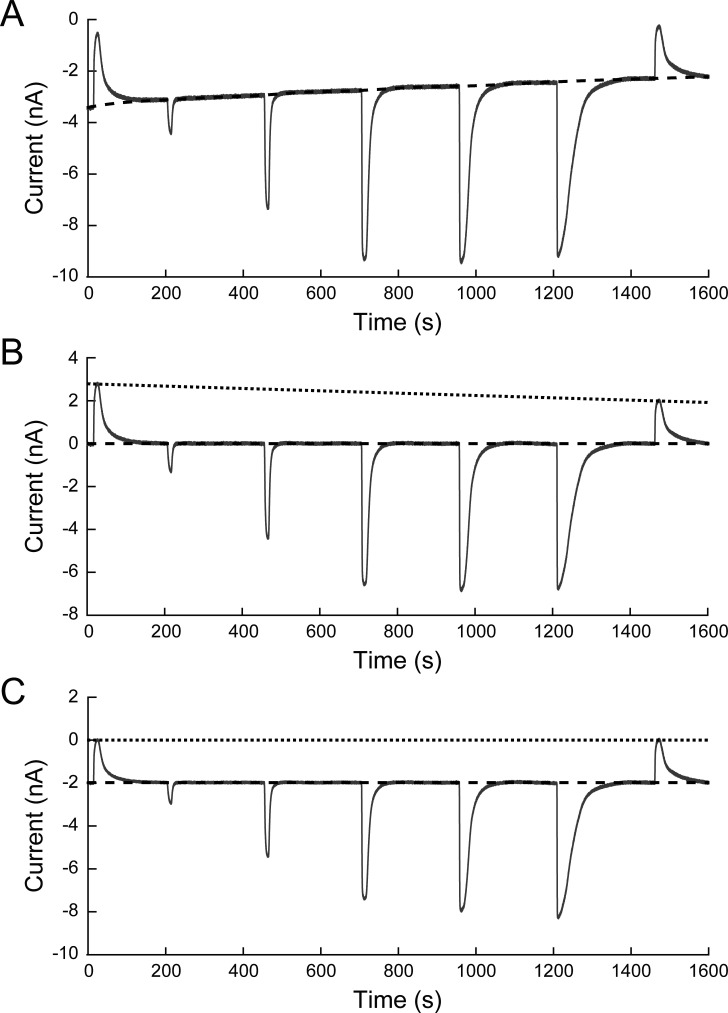
Correction for baseline drift and current rundown.(A) Raw two-electrode voltage clamp current recording from α1L9'T/K278Aβ2γ2L receptors expressed in a Xenopus laevis oocyte. Responses to 10 second pulses of increasing concentrations of GABA (0.1, 1, 10, 100, and 1000 μM) were bookended by 10 second pulses of 1 mM PTX as shown in Figure 2. (B) Baseline drift was corrected by subtracting a spline fit to selected segments of baseline (dashed line in A). (C) Current rundown was corrected by linearly scaling the current record, so that the bookending PTX responses were of equal amplitude (dotted line in B). The resulting current trace was shifted, so that zero current coincides with the peak response to block by PTX.